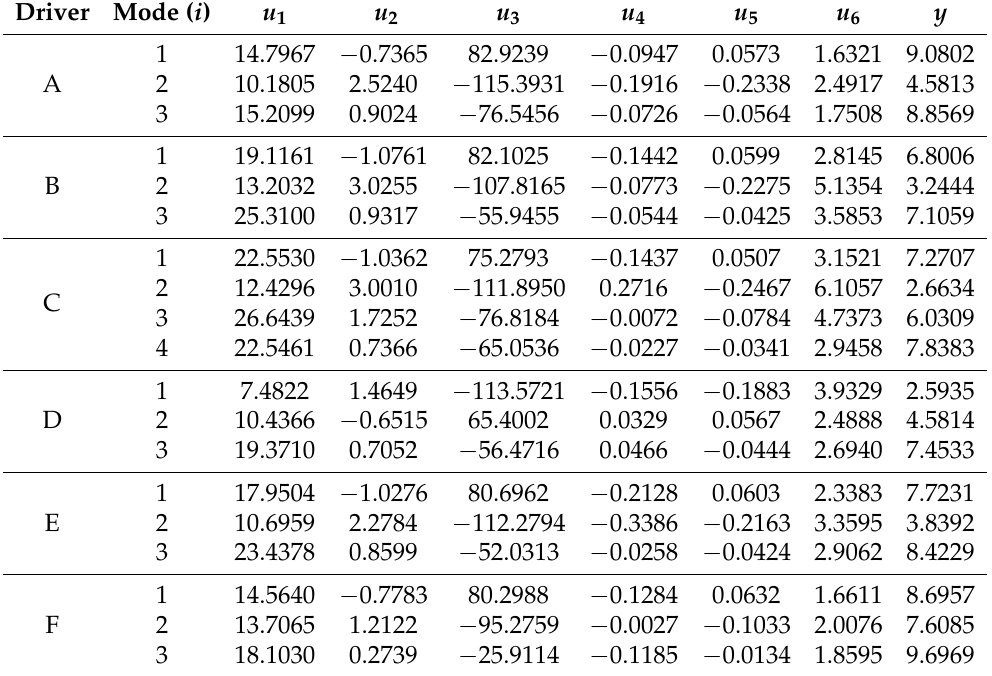
Table 2. Mean values of the variables in each mode i .